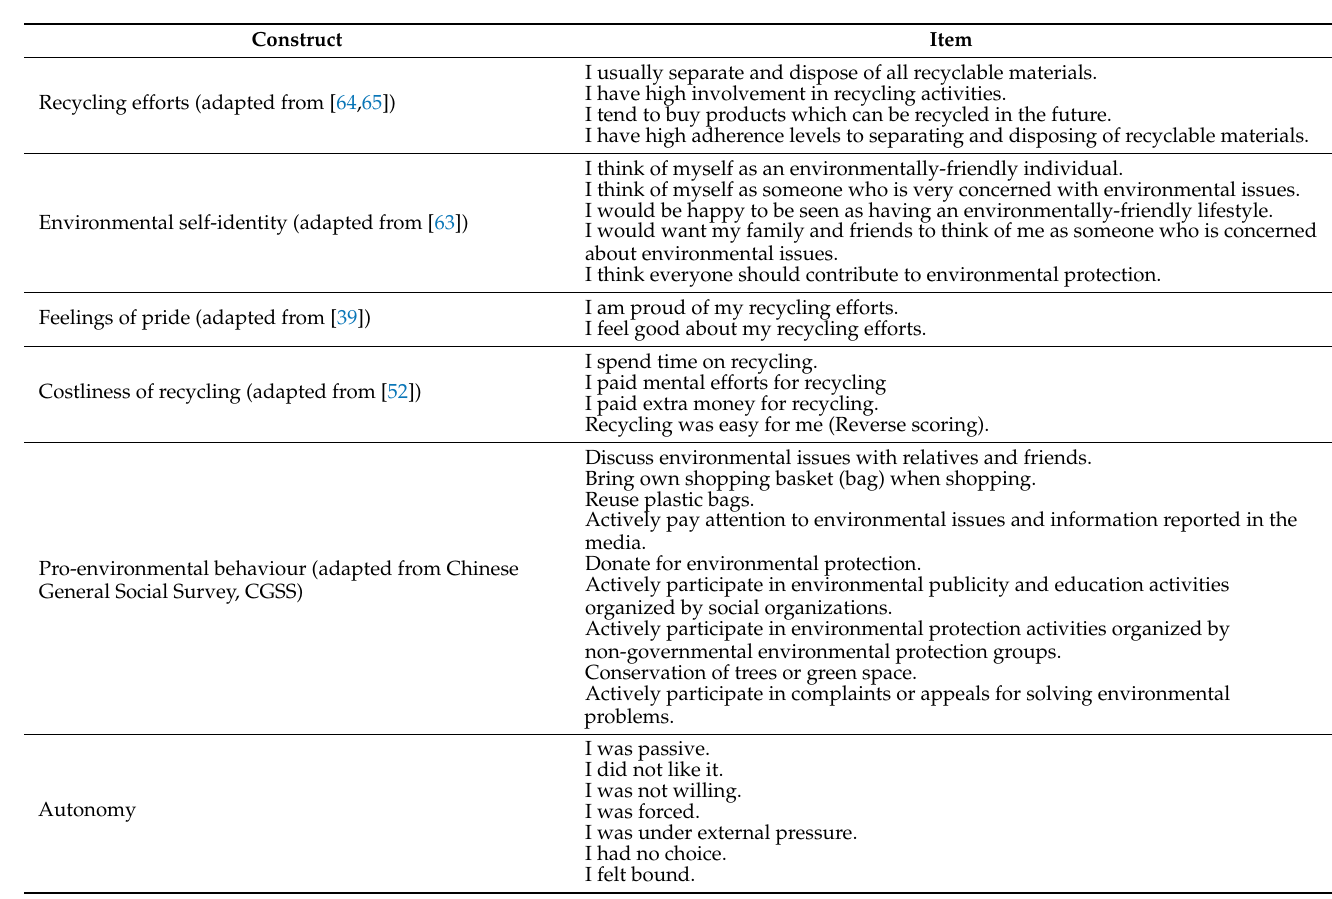
Table 1. Constructs and